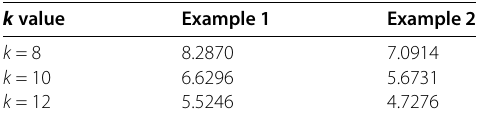
Table 1 The settling time ¯